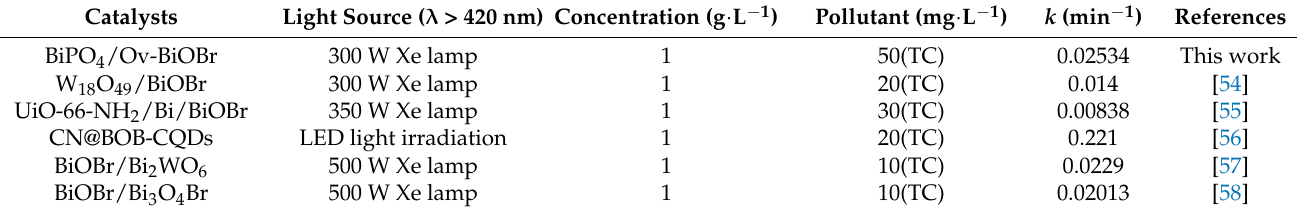
Table 1. Recent work of BiOBr-based heterojunctions in degradation of TC.